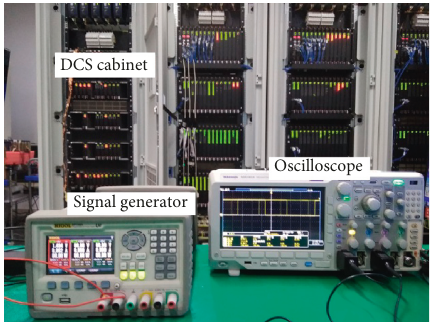
Figure 8: Photo of physical test